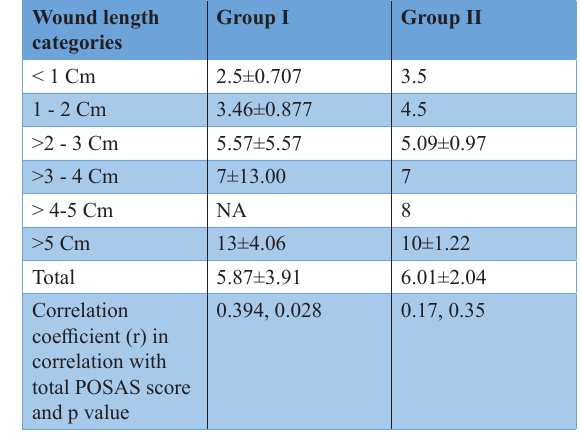
Figure 1. Flow chart of plan of selection,